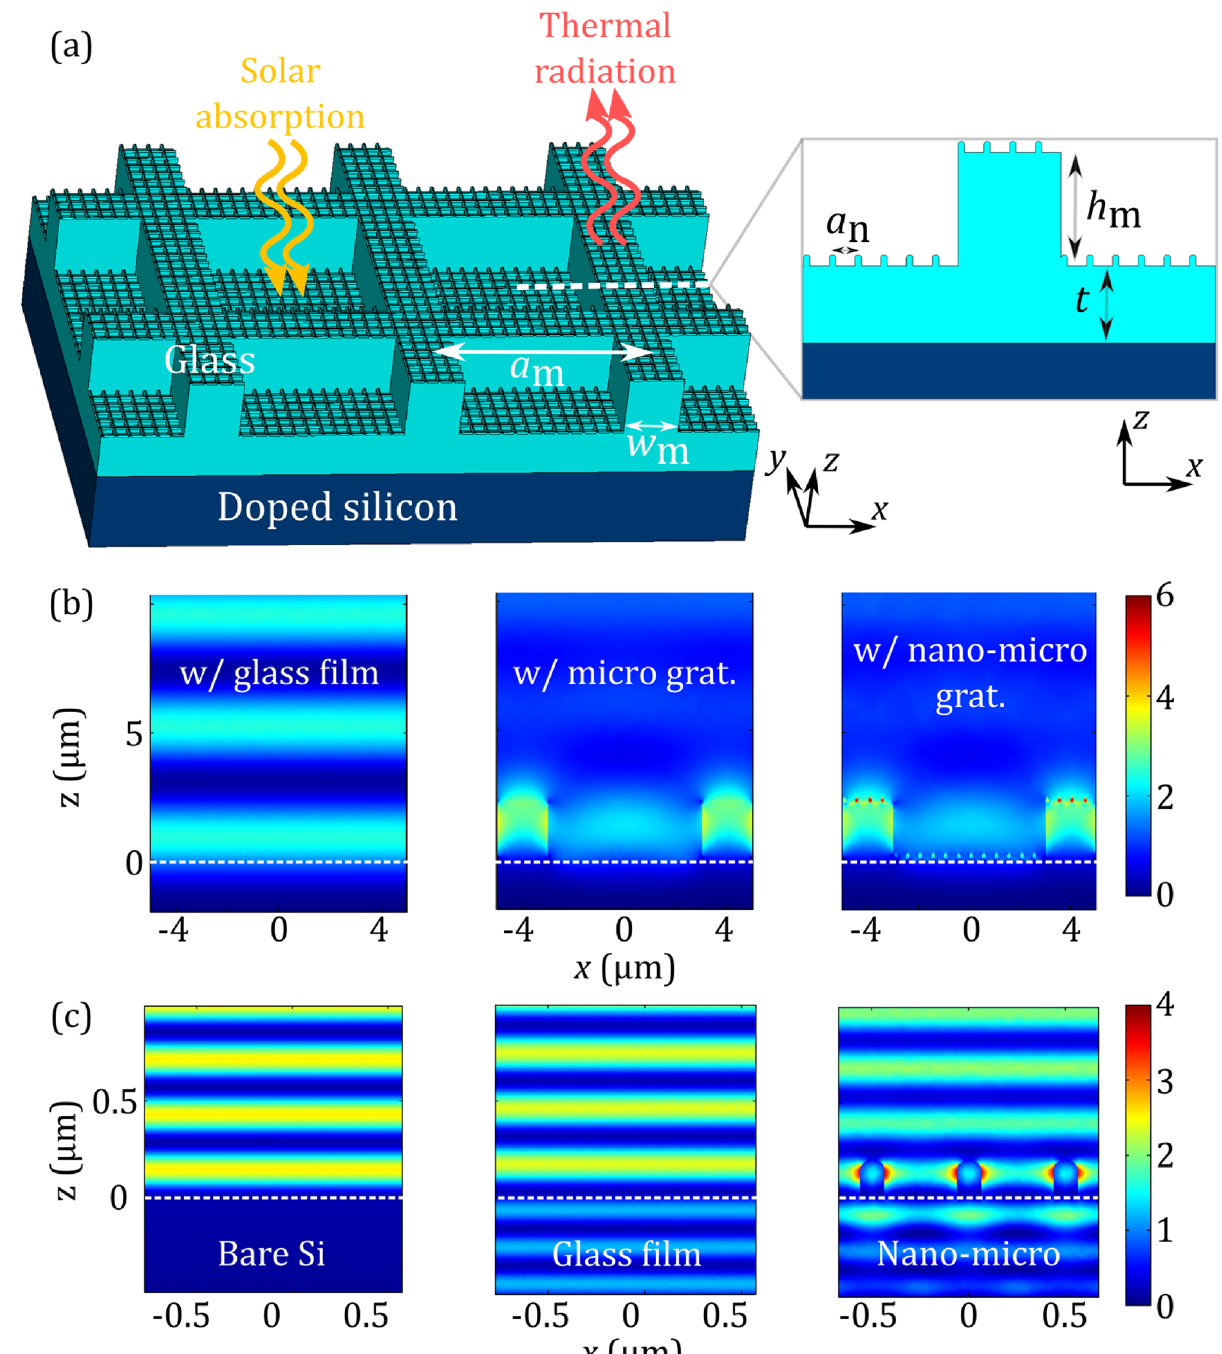
Figure 1. ( a ) Schematic of the nano-micro-structured glass grating coating atop of a doped Si layer, and a vertical cross-section of the micro-unit-cell. ( b , c ) Normalized (relative to the incident field, E 0 ) distribution of the squared amplitude of the electric field at λ = 8.7 μm, θ = 0° in ( b ) for a flat 3.7-μm-thick glass film on top of Si (left), the microstructured glass grating on top of Si (middle), and the nano-micro-structured glass grating on top of Si (right) cases, and λ = 0.58 μm, θ = 0° in ( c ) for the flat Si (left), flat 1.5-μm-thick glass film on top of Si (middle), and the nano-micro-structured glass grating on top of Si (right) cases. In ( c ) middle, we